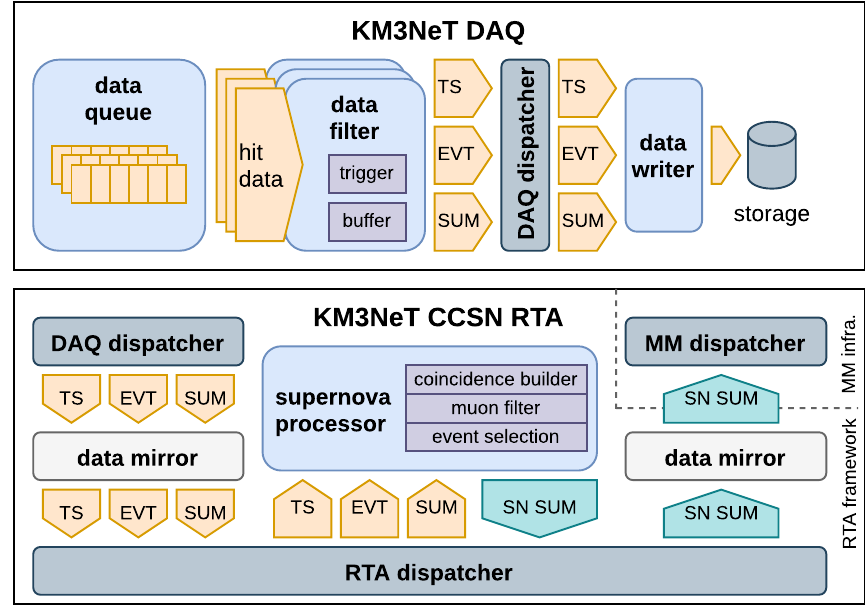
Fig. 1 Logic diagram of the data acquisition system of KM3NeT detectors (top) and the CCSN real-time analysis (RTA) framework (bottom) running at the computing farm of each detector’s shore station. The data streams are indicated with the following abbreviations: TS timeslices, EVT triggered events, SUM summaryslices (PMT rates), SN SUM supernova summary. The dashed line separates the local processing framework from the common KM3NeT multi-messenger